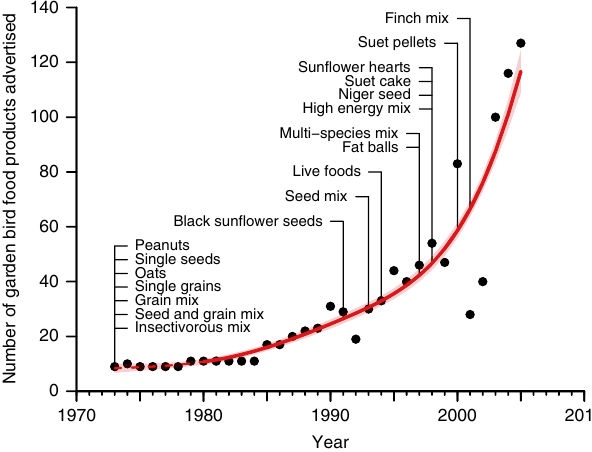
Fig. 1 Changes to the British garden bird feeding industry over time.